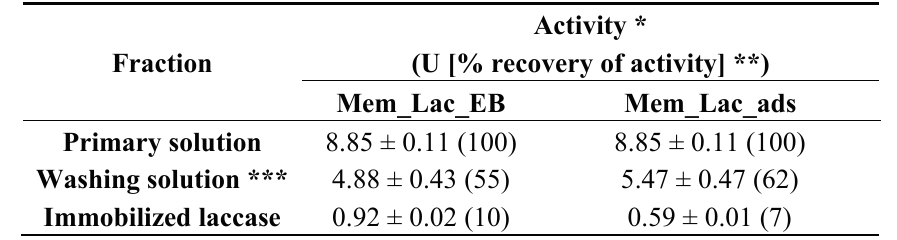
Table 2. Distribution of laccase activity within different fractions resulting from laccase immobilization on membranes by E-Beam and physical adsorption. Activity * Fraction (U [% recovery of activity] **) Mem_Lac_EB Mem_Lac_ads Primary solution 8.85 ± 0.11 (100) 8.85 ± 0.11 (100) Washing solution *** 4.88 ± 0.43 (55) 5.47 ± 0.47 (62) Immobilized laccase 0.92 ± 0.02 (10) 0.59 ± 0.01 (7) * Data represent means ± standard deviations for triplicate determinations. ** % of initial activity in the primary solution used for immobilization. *** Total laccase activity recovered from the washing steps applied after immobilization (please refer to the experimental section for